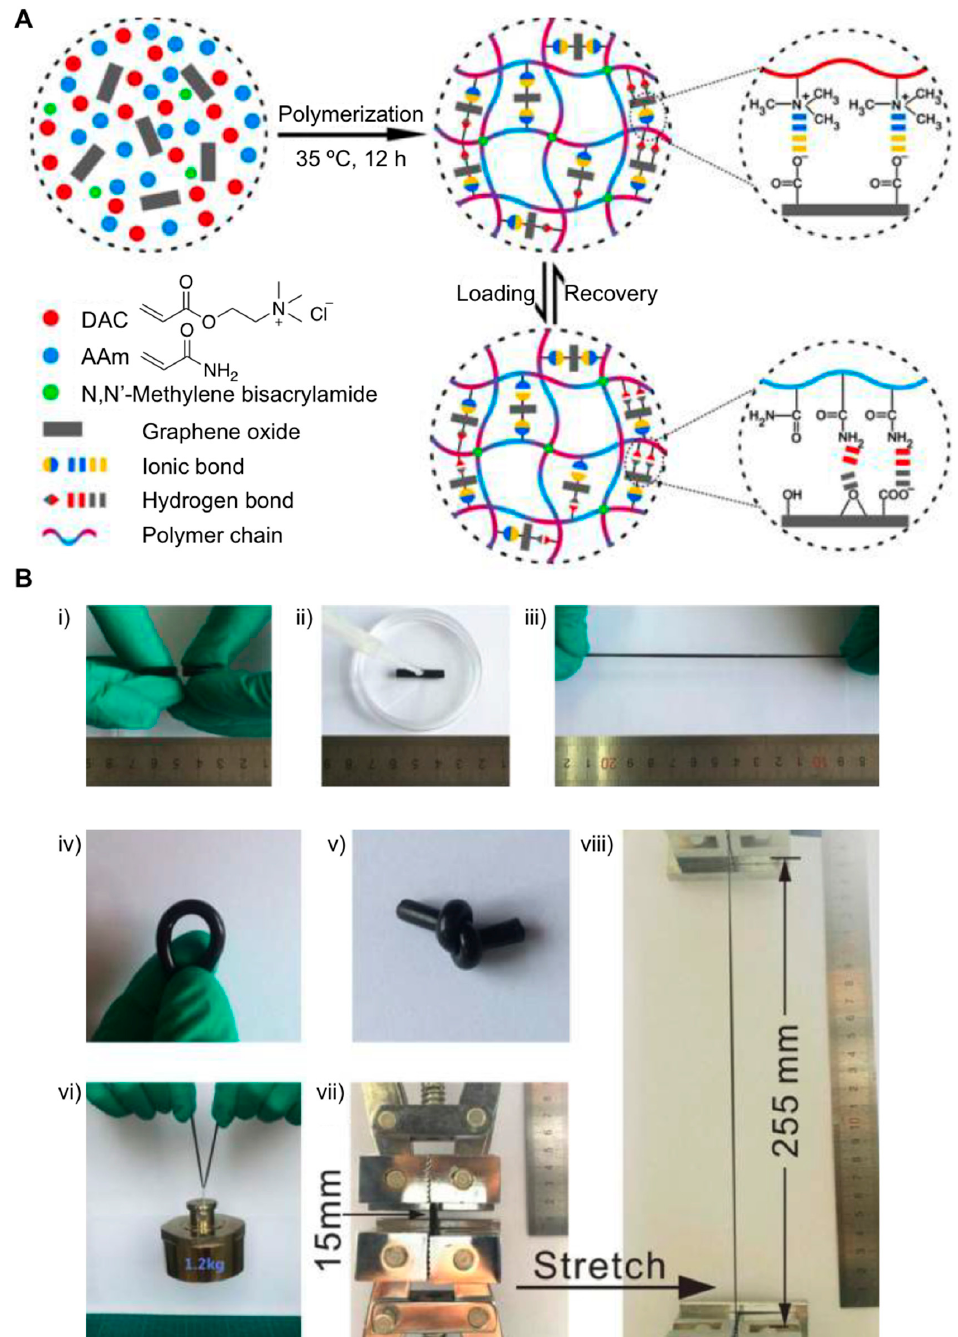
Figure 4. ( A ) Schematics of preparation of hydrogel copolymerization of AAm, DAC and MBAAm in the presence of graphene oxide (GO) along with a proposed molecular mechanism of the loading and recovery process. The ionic bonds and hydrogen bonds contribute to the high mechanical properties and self-healing properties. ( B ) ( i – iii ) Self-healing properties of the hydrogels: ( i ) A pristine cylinder of the A 1 D 2 G 1 sample was cut in half; ( ii ) the two-halves were simply made to contact, and a drop of water as dropped on the cut surface; ( iii ) after standing for hours, the sample can be stretched to a large strain by hand. ( iv – viii ) A 1 D 2 G 1 hydrogels can be ( iv ) bent, ( v ) knotted, ( vi ) loaded, and ( vii ) stretched. Nomenclature of hydrogels: A x D y G z , where A, D, and G represent AAm, DAC, and GO, respectively; x and y refer to the mass ratio of AAm and DAC; z represents the GO content. Adapted with permission from Reference [48]. Copyright 2017 American Chemical Society.